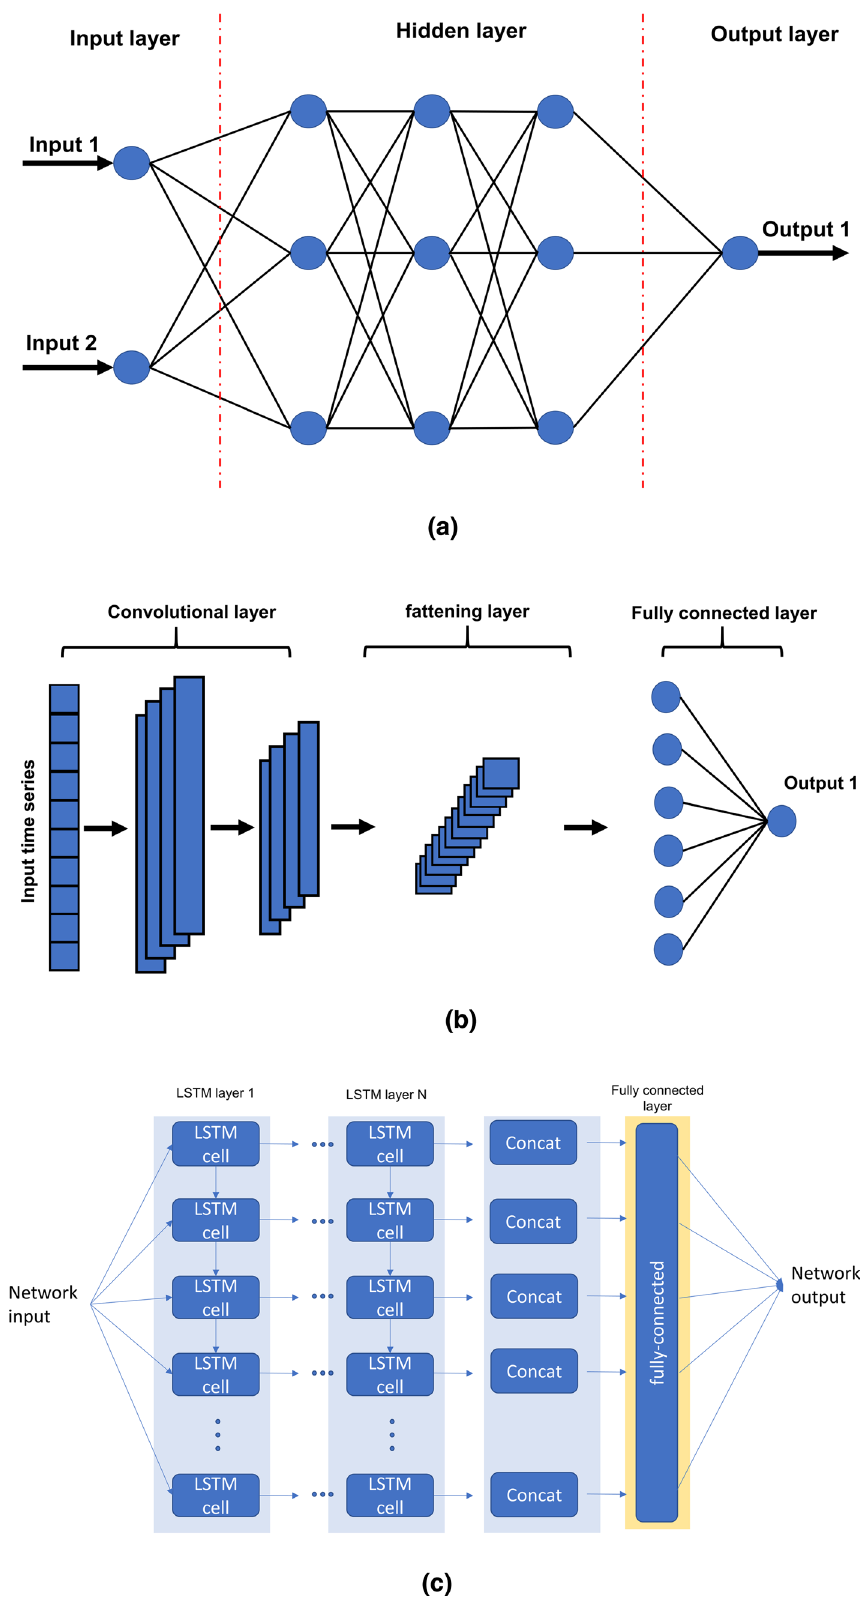
Fig. 4 Schematic diagram of a artificial neural network (ANN), b convolutional neural network (CNN), and c long short-term memory